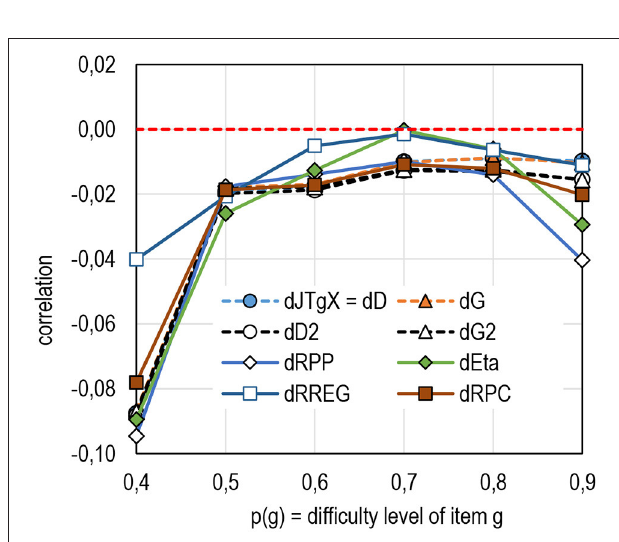
FIGURE 9 | The average difference between the sample and population by the item difficulty (k = 6,932).